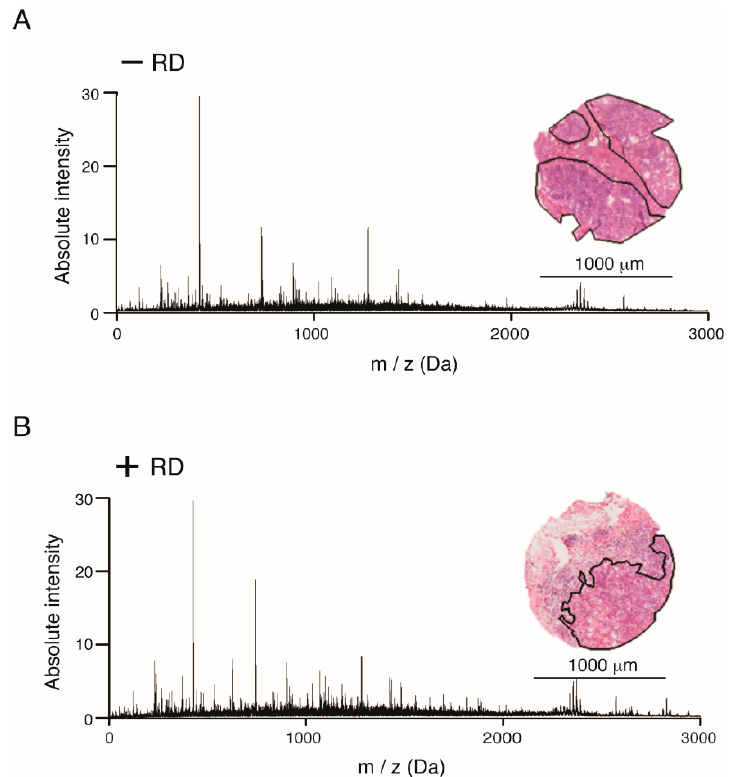
Figure 1. Average spectra of representative MALDI-imaging proteomic profiles of primary tumor sections from either ( A ) patients without or ( B ) with recurrent disease. For each group, examples of H&E images with indicated malignant areas measured are included. In total, 506 m/z values in a mass range between m/z 600 and 3000 (signal/noise > 1) were extracted by peak picking from high-grade serous ovarian cancer (HGSOC) at early-stage human tissue. Analyses were performed with 20 biologically independent spots (N = 10 each patient group).